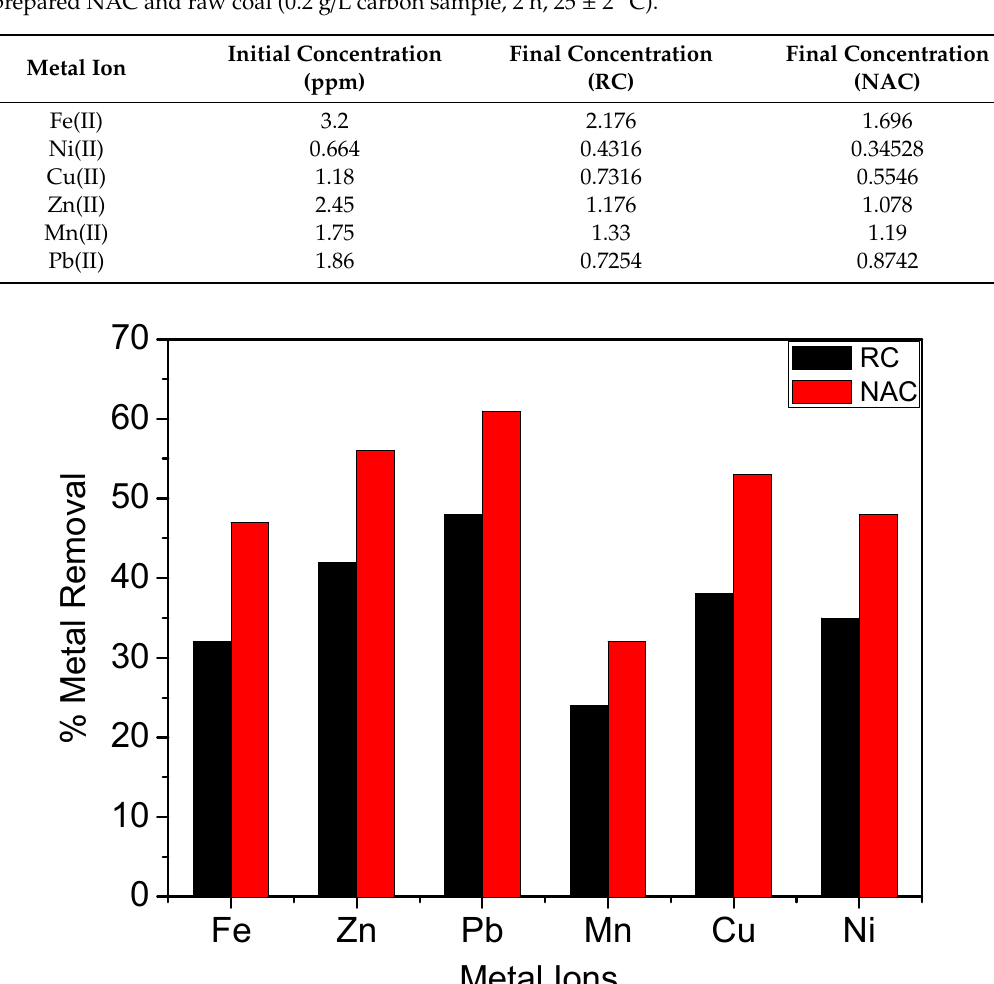
Table 6. Heavy metal ions decontamination from petrochemicals discharged waste water using